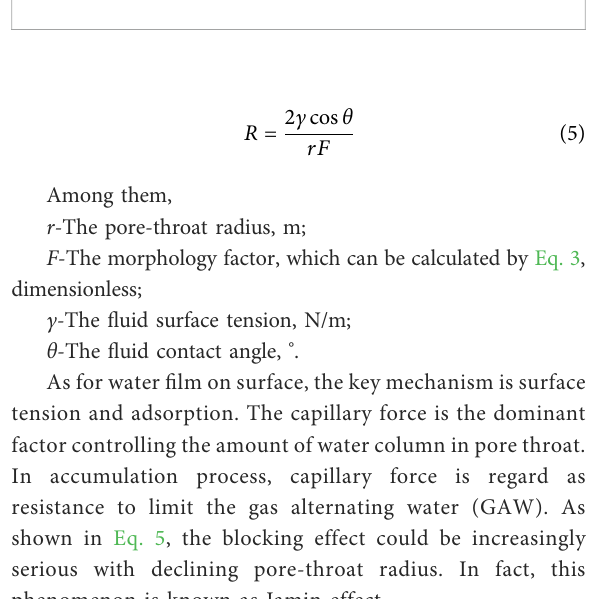
FIGURE 12 The distribution of pore size with different residual water